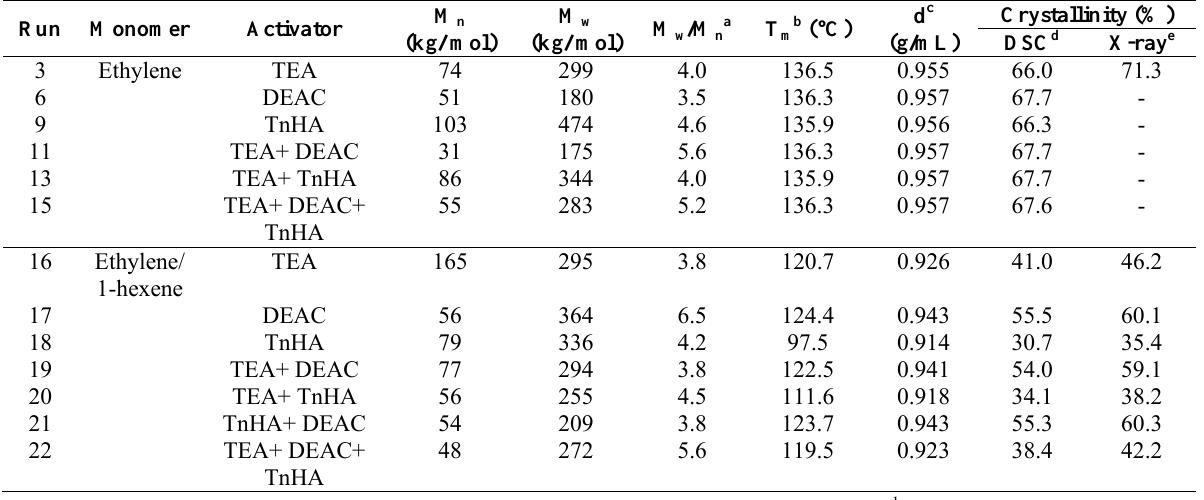
, M and polydispersity (M W n